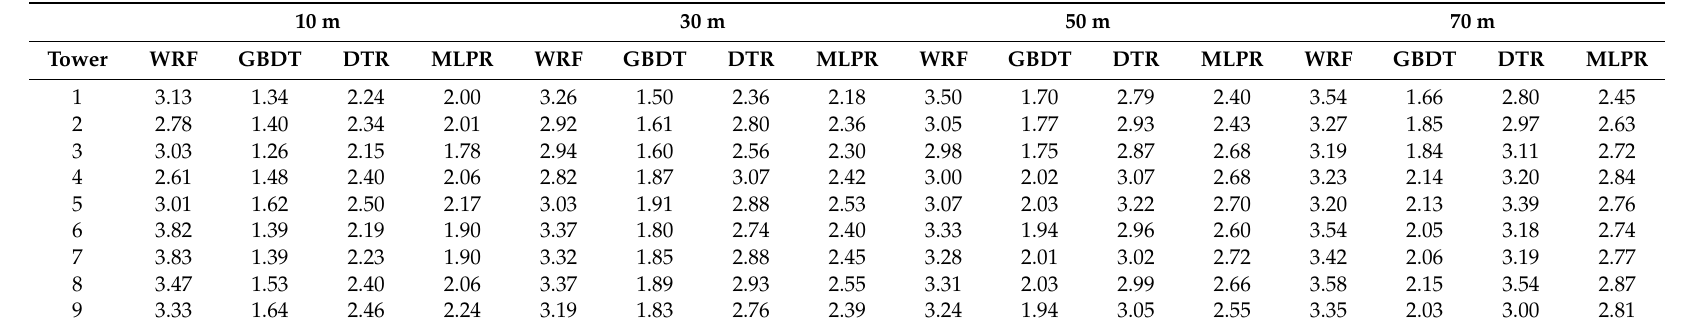
Table A2. The 24–48 h RMSE (m / s) of WRF model original output and post-processing model